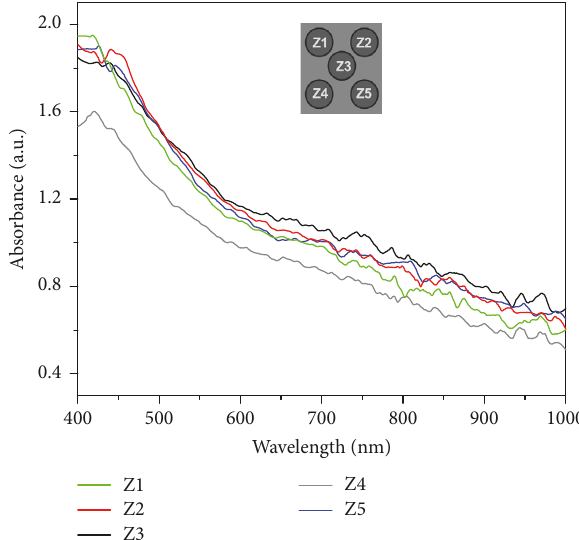
Figure 7: UV-Vis electronic absorption spectra measured in 5 different areas of NiCo 2 O 4 film. The inset drawing indicates the 5 analyzed zones.